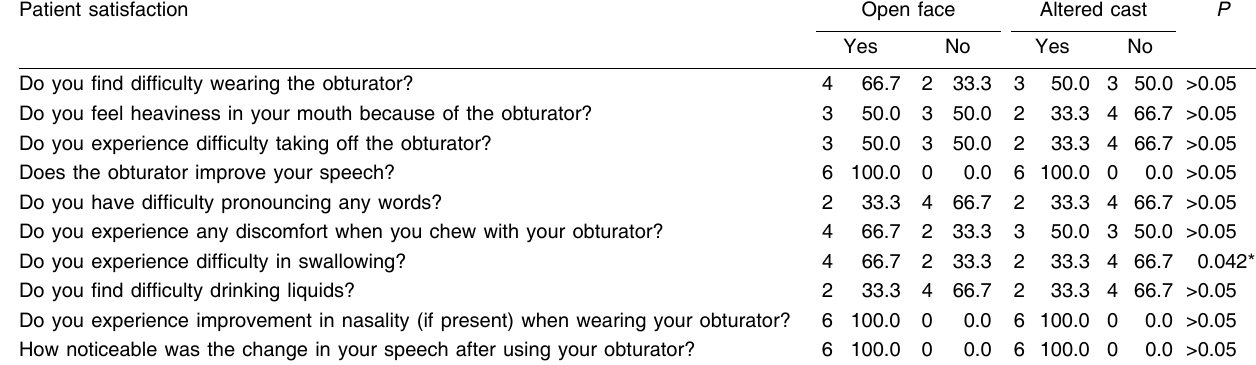
Table 5 Comparison between the open face impression technique and the altered cast impression technique with regard to patient